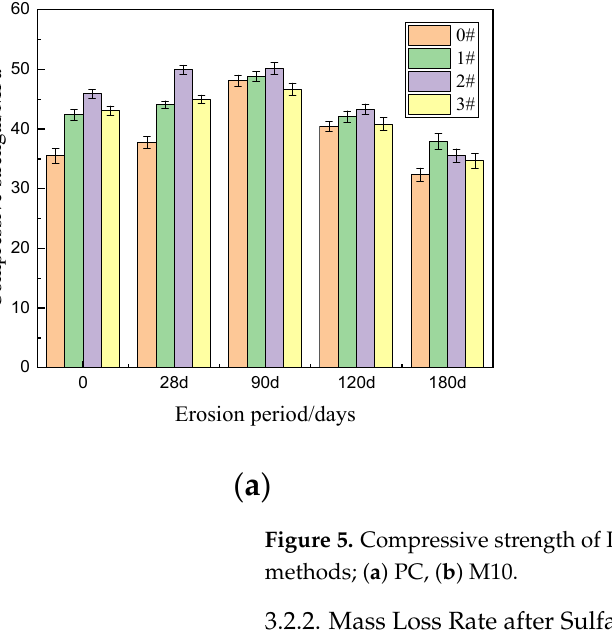
( d ) Figure 4. Compressive strength of cement mortar after a different erosion period under different curing methods; ( a ) 0#, ( b ) 1#, ( c ) 2#, ( d ) 3#.